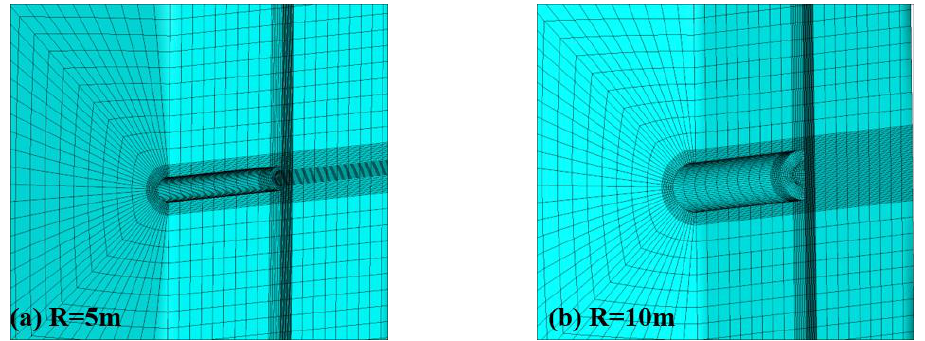
Figure 6. Model and meshing of the tunnel with radii of 5 and 10 m.